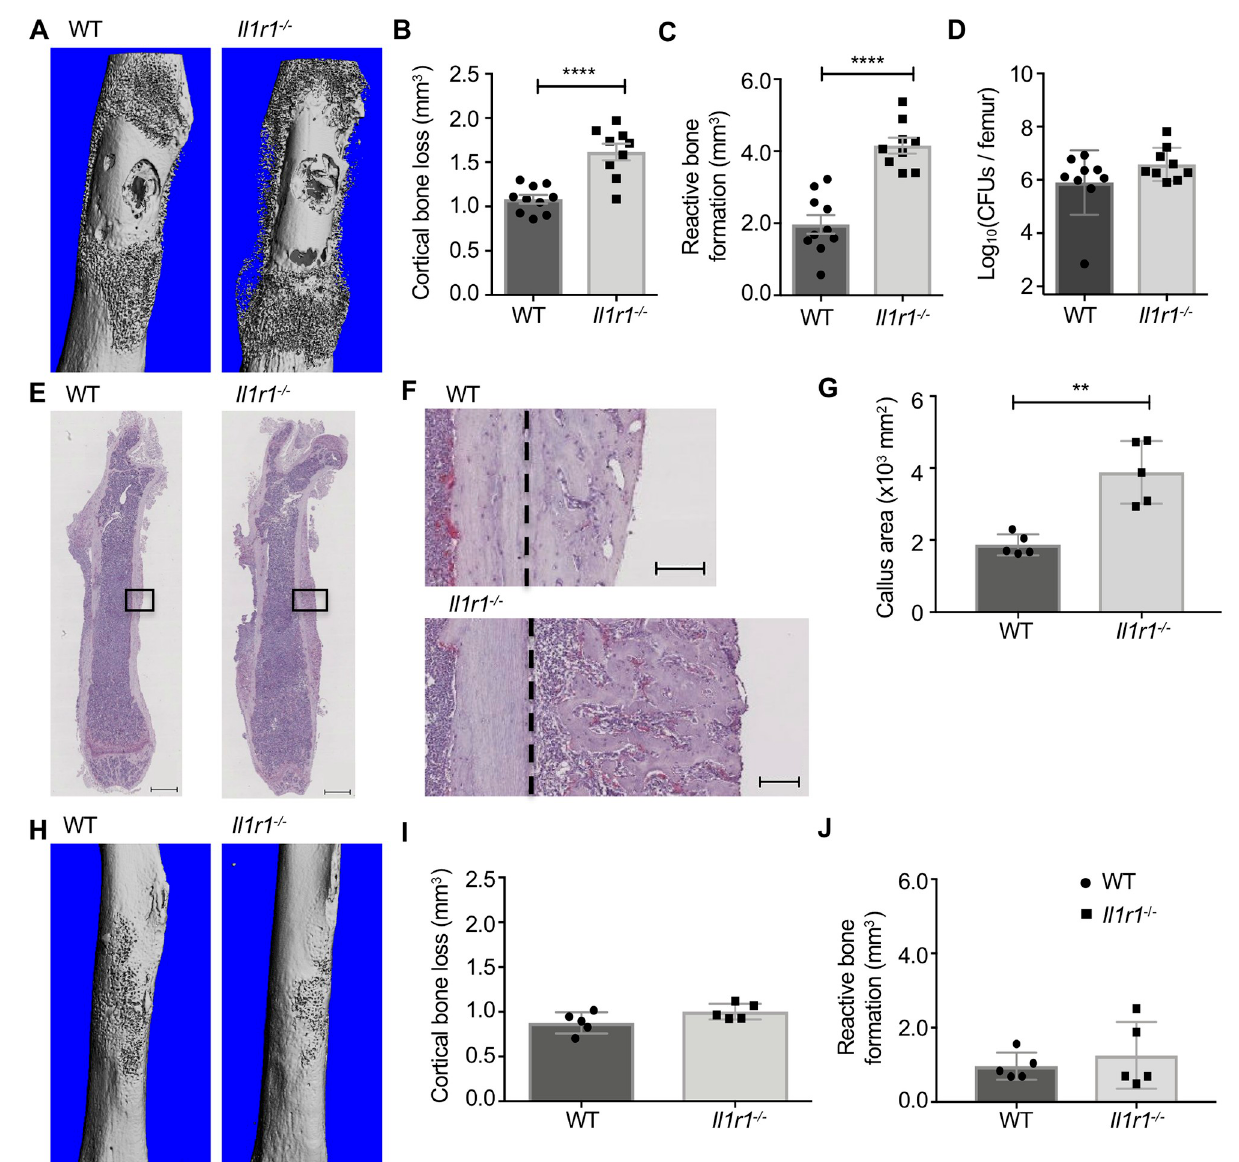
Fig 6. Loss of the IL-1R enhances cortical bone loss and reactive bone formation during S. aureus osteomyelitis. (A-J) To determine changes in bone remodeling and final bacterial burdens, female mice were infected with S. aureus (10 5 CFUs: WT n = 10, Il1r1 -/- n = 9; duplicate experiments for bone remodeling; WT n = 9, Il1r1 -/- n = 9; duplicate experiments for CFU enumeration) or mock infected (WT n = 5, Il1r1 -/- n = 5 for bone remodeling) with PBS. Femurs were harvested at day 14 post-infection and scanned using the μ CT50. Representative anteroposterior views of S. aureus infected femurs (A) and mock infected femurs (H). μ CT three-dimensional analysis of cortical bone loss (mm 3 ) and reactive bone formation (mm 3 ) between S. aureus infected (B, C) and mock infected (I, J) WT and Il1r1 -/- femurs. Bacterial burdens were quantified at day 14 post-infection from WT and Il1r1 -/- femurs (D). (E, F) After μ CT analyses, histologic sections of the S. aureus infected femurs were prepared and TRAP-stained. Slides were scanned using a Leica SCN400 Slide Scanner, with representative images shown taken at 0.58X (scale bars = 1 mm) (E) with the region in the black box imaged at 4X (scale bars = 100 μ m) (F), with dashed black line demarcating the separation of intact cortical bone (left of dashed line) and the callus (right of dashed line). (G) Tissue IA 2.0 software was used to image callus area of infected femurs at 20X (10 5 CFUs; n = 5 per genotype). Symbols represent individual data points from each mouse (WT = circles; Il1r1 -/- = squares), the top line of each bar represents the mean, and error bars represent standard deviation. Unpaired t -tests were used to compare CFU burdens, μ CT analyses, and Tissue IA 2.0 measurements between WT and Il1r1 -/- mice. �� p < 0.01, ���� p < 0.0001.